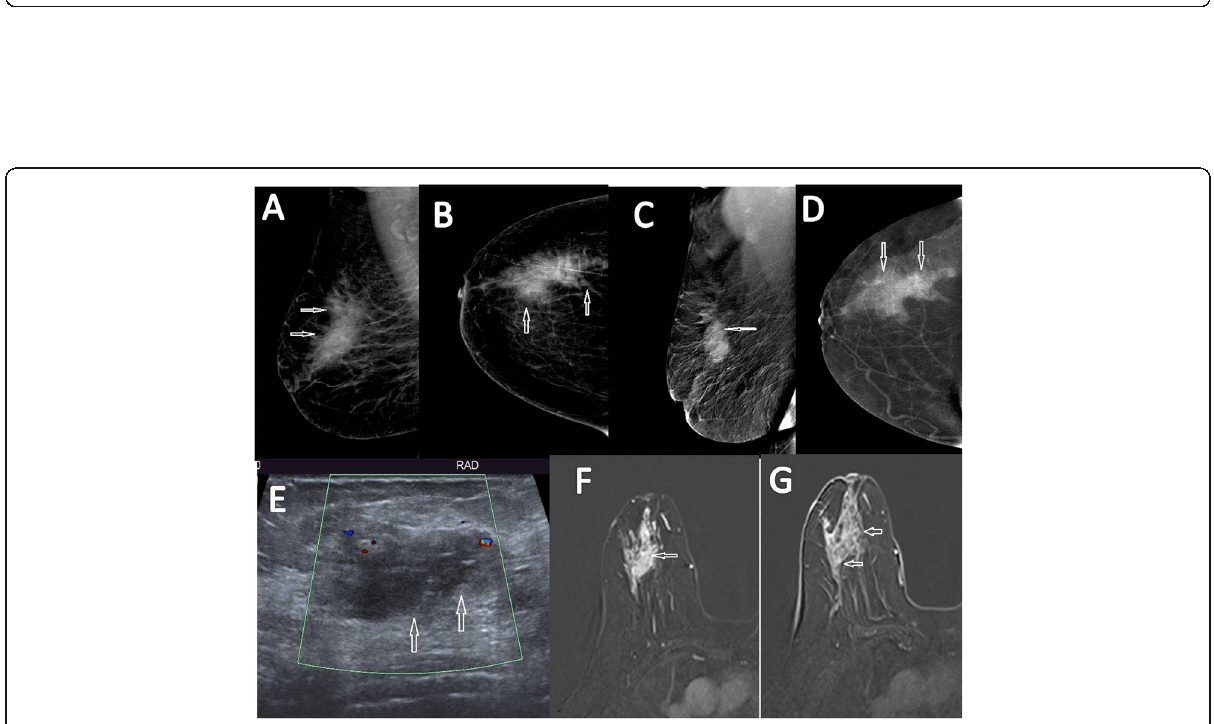
Fig. 5 Female patient 54 years old, she was presented with right breast mass. On ultrasound ( a ), there was a complex well-defined cystic lesion with soft tissue component at 12 o ’ clock (arrow), which shows flow on the color Doppler study. On CESM ( b , c ), the lesion shows intense enhancement of the solid component (arrows) with enlarged right axillary LNS (asterisk). A small enhancing satellite lesion is seen anterior to the lesion (short arrow). On MRI with IV contrast ( e , f ), the lesion appears complex cystic with enhanced large soft tissue component of dynamic curve type II and III (arrows). The satellite lesion is seen anterior and medial to the lesion (small arrow) with thickening enhancing overlying skin and enlarged pathological rounded axillary LNS (asterisk). A biopsy was done and histopathologically proven as intraductal papillary